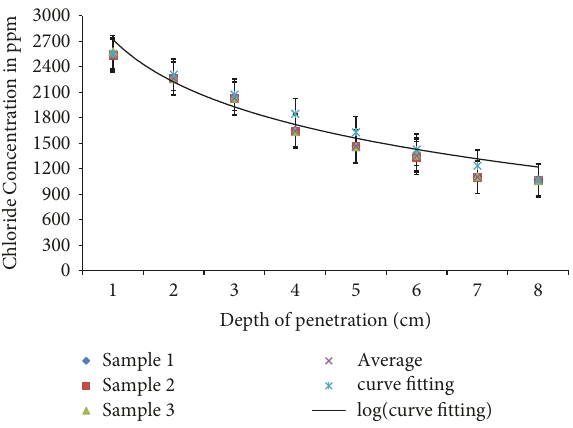
Figure 5: Error function fitting curve for OPC-H 2 O.